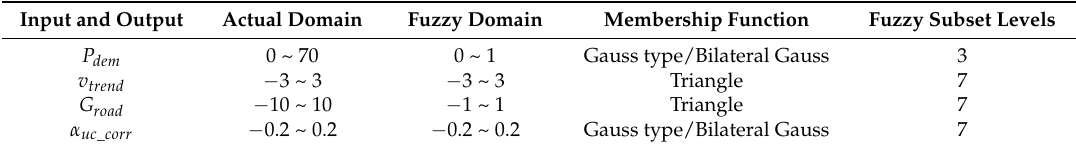
Table 6. Input and output variables definition of fuzzy controller.